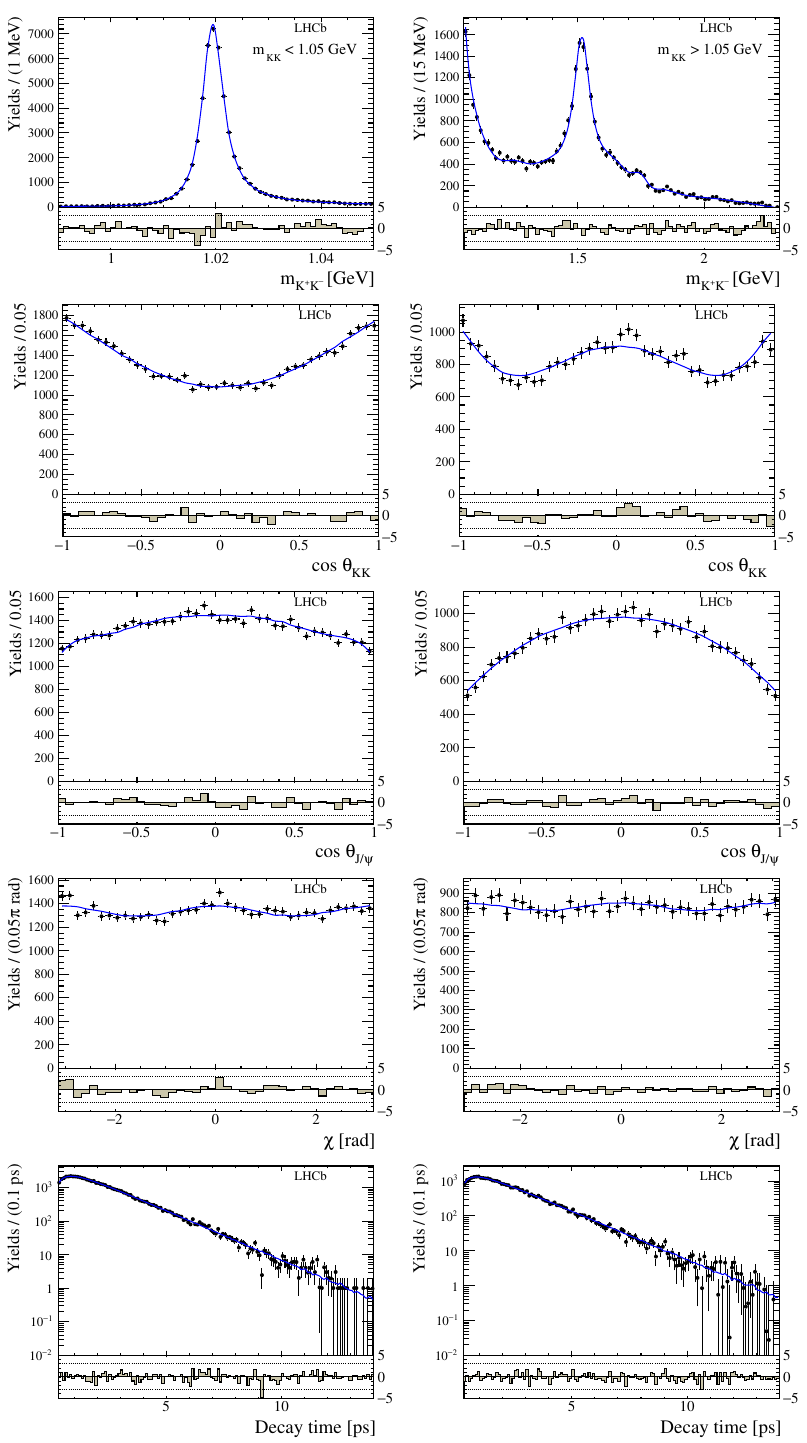
Figure 6 . Projections of the (cid:12)tting variables in the (left) low-mass ( (cid:30) (1020)) and (right) high-mass regions shown by the solid (blue) curves. The points with error bars are the data. At the bottom of each (cid:12)gure the di(cid:11)erences between the data and the (cid:12)t divided by the uncertainty in the data are shown.